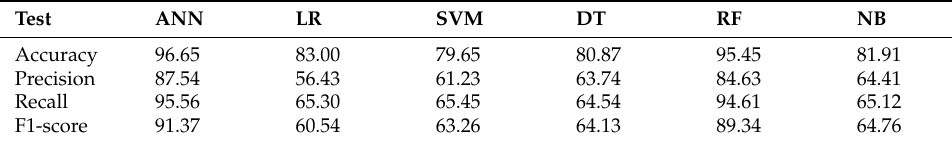
Table 11. Test results for the six classifiers for prediction of donors return.